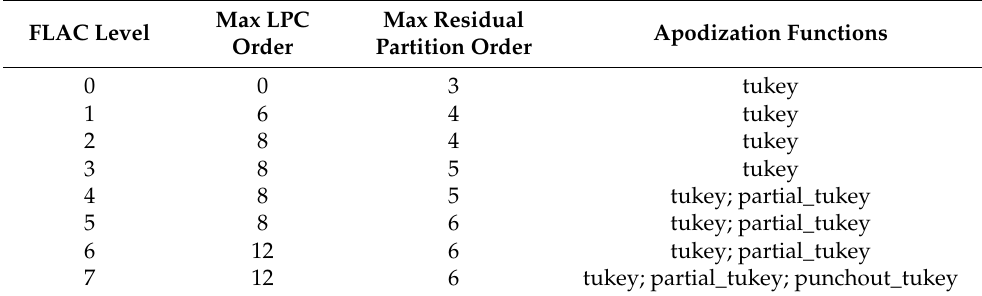
Table 3. Parameters corresponding to the various FLAC compression levels as used in this work. They differ slightly from the reference implementation due to the embedded system restrictions and to the fact that we use a 3-channel setup, thus rendering “tricks” such as joint-stereo inapplicable. Max LPC Max Residual FLAC Level Apodization Order Partition Order